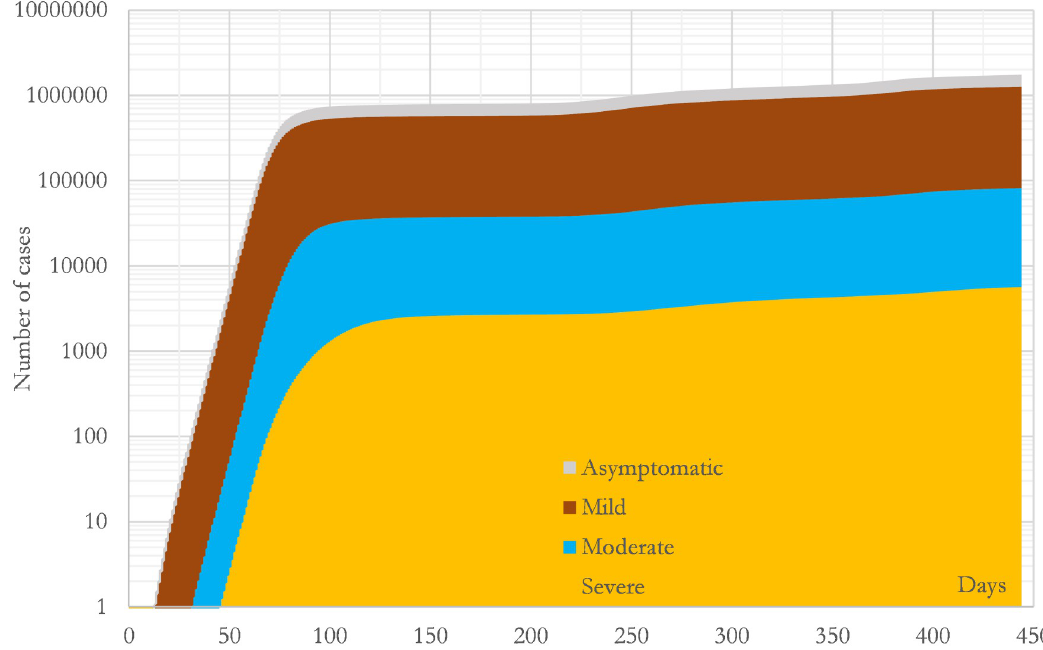
Fig 7. Calculated evolution of the accumulated prevalence during the studied period in the region of Madrid (CM). The curves are cumulative and present the number of recovered individuals segregated by types. All the curves have been calculated with the convolution mathematical model presented in this study using the parameters collected in Table